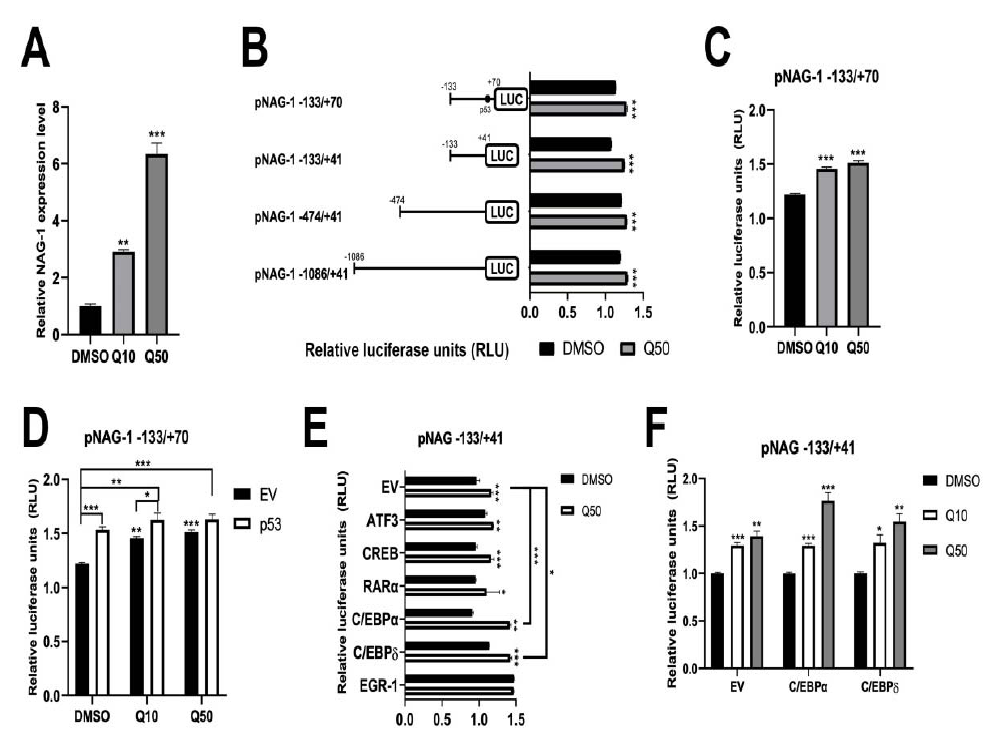
Figure 5. Quercetin increased NAG-1 promoter activity. ( A ) Quercetin increased NAG-1 expression at the transcriptional level. GAPDH was used as a control. DMSO, vehicle; Q10, 10 µ M quercetin; Q50, 50 µ M quercetin. Data are representative of three independent samples. ** p < 0.01 and *** p < 0.001. ( B ) The pNAG-133/+70/LUC, pNAG-133/+41/LUC, pNAG- 474/+41/LUC, pNAG-1086/+41/LUC, and pRL null constructs were co-transfected into BCPAP cells, and cells were treated with dimethyl sulfoxide (DMSO) or Q50. Luciferase activity was measured using the Dual-Luciferase system. The X-axis represents relative luciferase units, and the schematic diagram of the NAG-1 promoter is indicated on the left of the figure. *** p < 0.001. ( C ) DMSO or quercetin (10 and 50 µ M) was treated in pNAG-1-133/+70/LUC containing the p53-binding site and pRL null-transfected BCPAP cells. *** p < 0.001. ( D ) BCPAP cells were co-transfected with pNAG-1-133/+70/LUC and pRL null constructs and then divided into two groups. One group was transfected with the empty vector (EV) and another group was transfected with the p53 expression vector. After 24 h of incubation, the transfected cells were treated with DMSO or quercetin for 24 h. * p < 0.05, ** p < 0.01, and *** p < 0.001. (E) BCPAP cells were co-transfected with pNAG-1-133/+41/LUC and pRL null constructs and then divided into two groups. One group was transfected with the empty vector (EV) and another group was transfected with ATF3, CREB, RAR α , C/EBP α , C/EBP δ , or EGR-1 expression vector. After 24 h of stabilization, the transfected cells were treated with DMSO or quercetin. Data are representative of three independent samples. * p < 0.05, ** p < 0.01, and *** p < 0.001. ( F ) pNAG-1 -133/+41/LUC- and pRL null-transfected BCPAP cells were treated with DMSO or quercetin (10 and 50 µ M). Data are representative of three independent samples. All the luciferase experiments were conducted and represented as * p < 0.05, ** p < 0.01, and *** p <